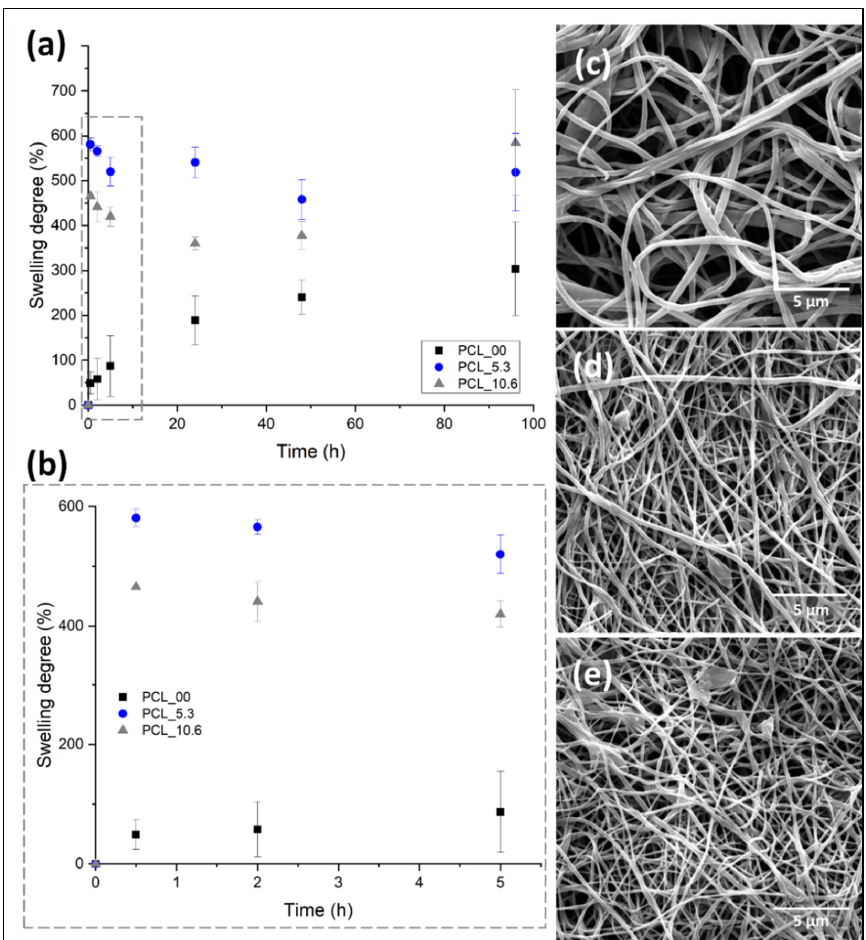
Figure 8. Degree of swelling for PCL/ P. major electrospun mats as a function of the immersion time in phosphate buffer solution—PBS (pH: 7.4): ( a ) 96 h of the assay, ( b ) first 5 h of swelling assay; SEM images of PCL/P. major electrospun mats after swelling assay (96 h): ( c ) PCL_10.6; ( d ) PCL_5.3, and ( e ) PCL_0.0.